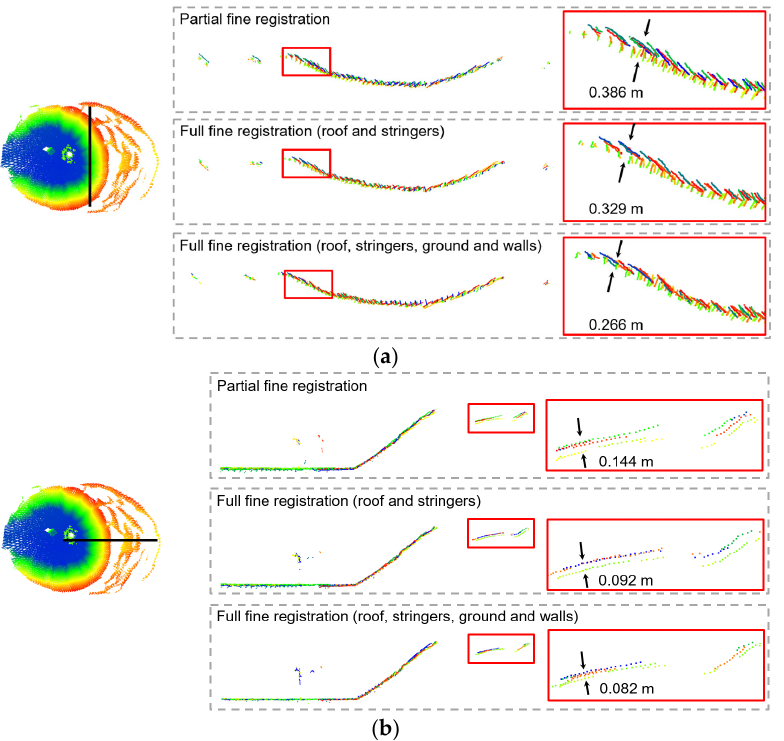
Figure 40. Extracted vertical profiles (width: 0.2 m) along the salt surface of the West Lafayette dataset before/after the full fine registration (the arrows indicate the direction of the measured distance): ( a ) profile orthogonal to the entrance walls and ( b ) profile parallel to the entrance walls.